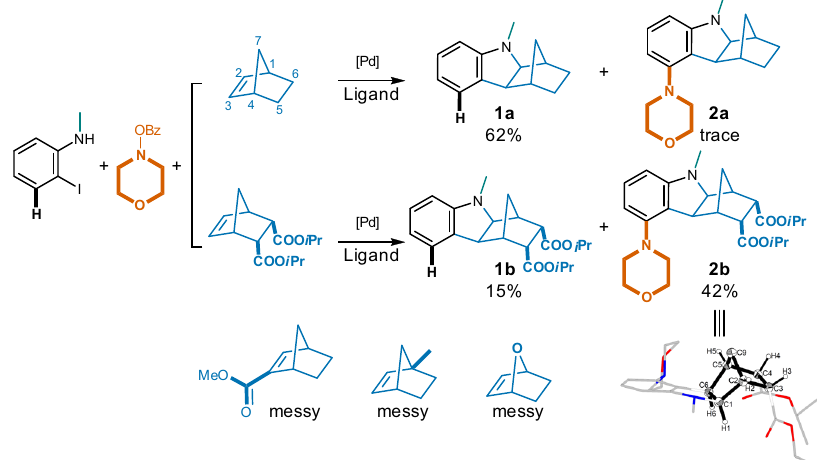
Fig. 3 Initial investigations on NBE analogs capable of ortho C(sp 2 )-H activation to synthesize the 5-substituted hexahydro-1 H -1,4- methanocarbazoles. Reaction conditions: 2-iodo- N -methylaniline (1.0 eq.), NBE analog (1.0 eq.), morpholino benzoate (1.3 eq.), Pd(OAc) 2 (5% eq.), PPh 3 (10% eq.), NaO t Bu (2.5 eq.), acetonitrile, 100 o C, 12